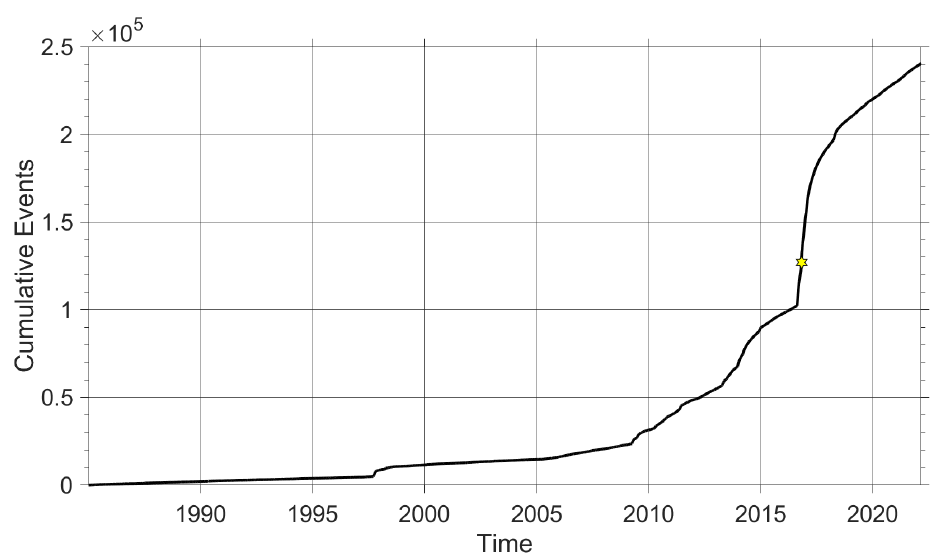
Figure 1. Representation of cumulative curve of events, with a time range from 1985 to 2022. The star represents the Norcia M6.5 earthquake, which was the strongest event of the 2016/2017 central Italy seismic sequence.